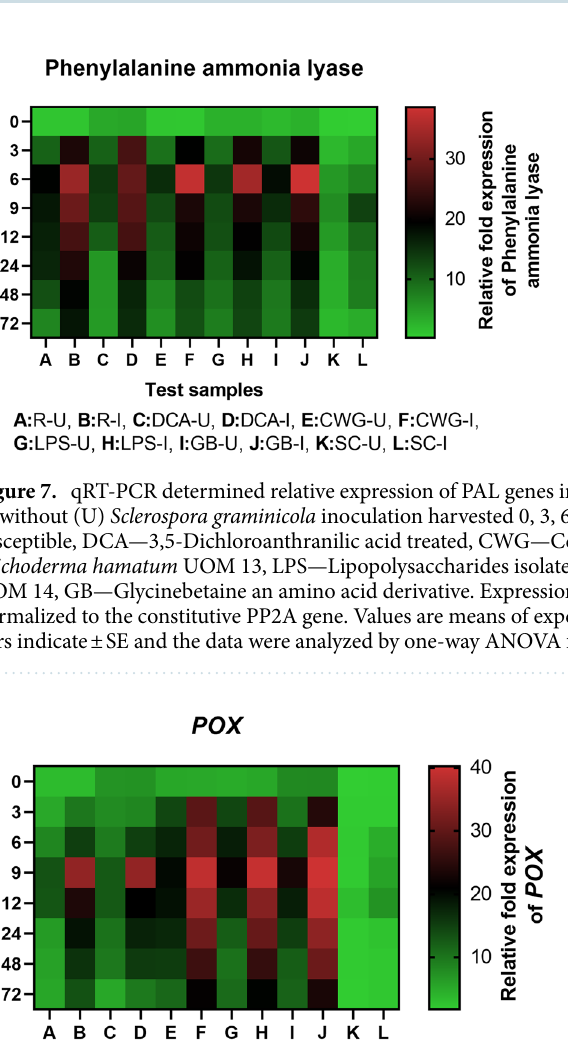
compared to the uninoculated samples at all time points (Fig. 9). Among the pathogen inoculated seedlings, at 24 hpi, resistant seedlings recorded highest PPO gene expression which was 6.08-folds higher than that of the control. And at 24 hpi, among the elicitor treated seedlings, highest PPO gene expression was observed in GB treated seedlings followed by LPS, CWG, and DCA treatments, which were 5.36-, 5.24-, 4.79- and 4.04-folds higher than that of the susceptible control seedlings, respectively. In seedlings without pathogen inoculation, pattern of PPO expression was similar to that of pathogen inocu- lated seedling but the level of expression was significantly lesser. At 24 h, PPO gene expression in pathogen inoculated GB, LPS, CWG, and DCA treated seedlings was 1.58-, 1.62-, 2.38-, and 2.29-folds higher than that of the uninoculated samples, respectively.